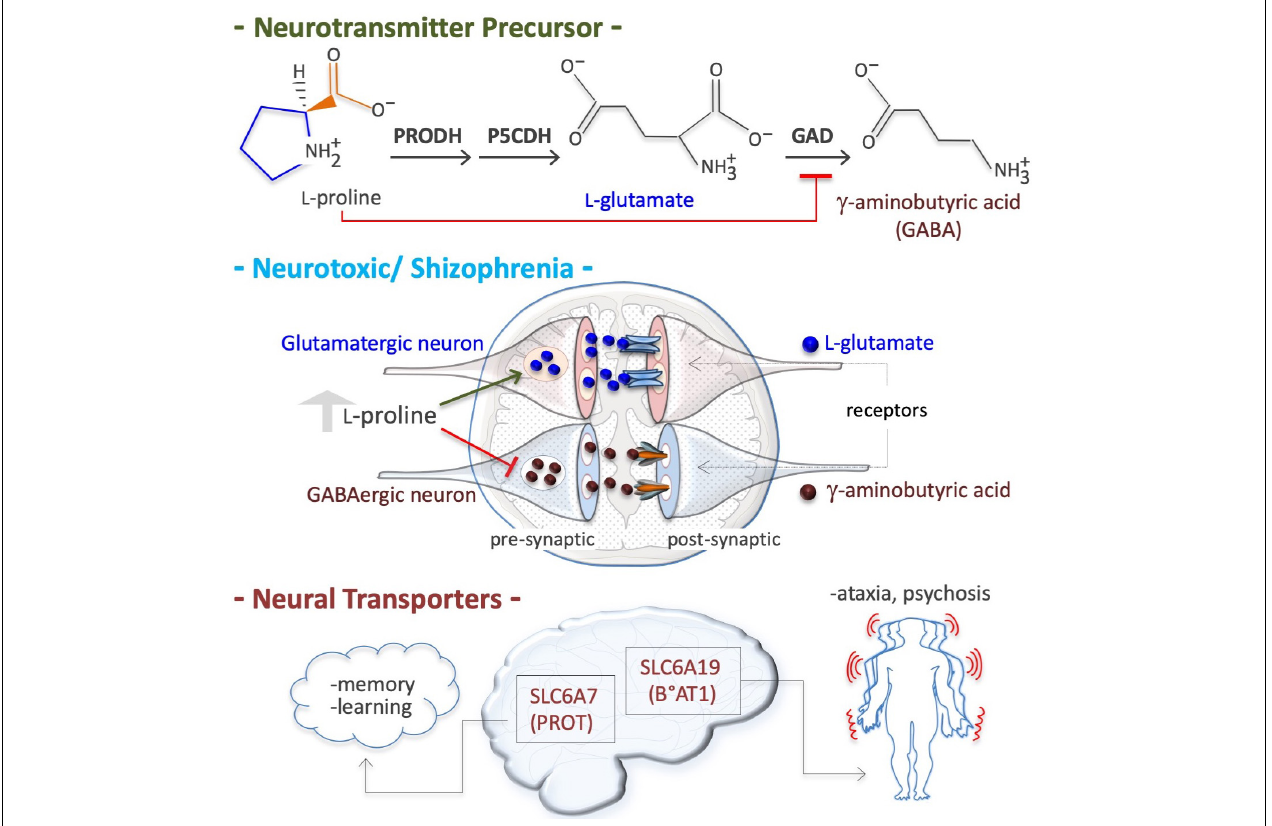
FIGURE 5 | Proline is a neural metabotoxin. Proline is a metabolic precursor of L -glutamate and gamma-aminobutyric acid (GABA), i.e., the two major neurotransmitters in mammalian brain ( top ) . At high plasma concentrations (2–3 millimolar instead of 150–200 micromolar), as occurs in patient suffering of hyperprolinemia type II (HPII, Table 3 ), the neurons can channeled free proline into glutamate biosynthesis, thus increasing free glutamate level. At a high level free proline can inhibit glutamate decarboxylase (GAD) enzyme (GABA biosynthesis) thus reducing GABA level in pre synaptic neurons. Altered levels of both these crucial neurotransmitters, and thus alterations in neurotransmission ( middle ) , can explain some of the symptoms of hyperprolinemic patients, including schizophrenia. Defects in neural proline transport, which is mediated by different transporters such as the solute carrier family 6 member 7 (SLC6A7), a high affinity proline transporter, also known as proline transporter 1 (PROT1), and by the solute carrier family 6 member 19 (SLC6A19), also known as system B(0) neutral amino acid transporter 1 (B0AT1), are associated with ataxia and